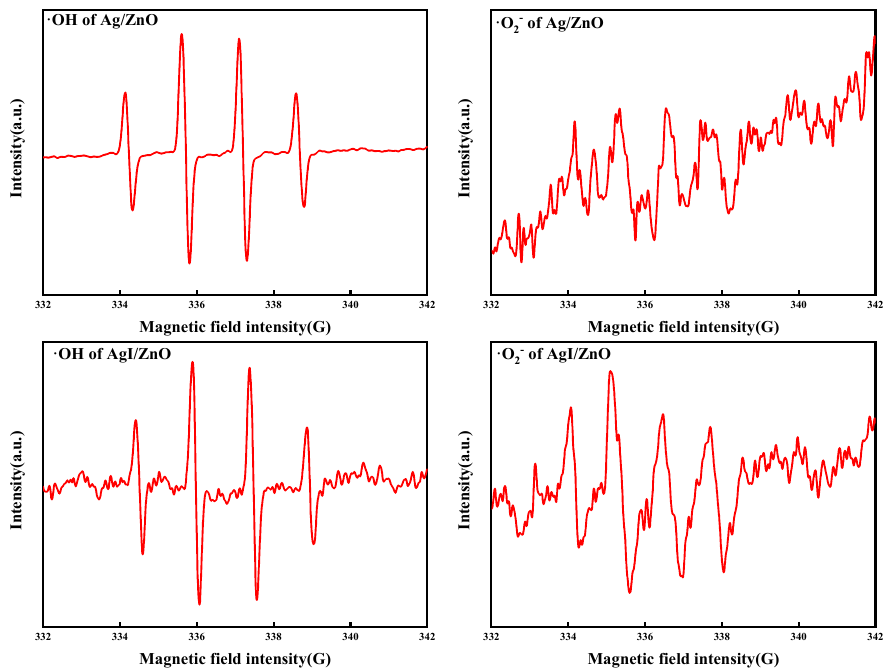
Figure 15. EPR patterns of OH and O 2 − in the photodegradation of MNZ under simulated sunlight irradiation with Ag/ZnO (100:1) and AgI/ZnO (X = 0.4).